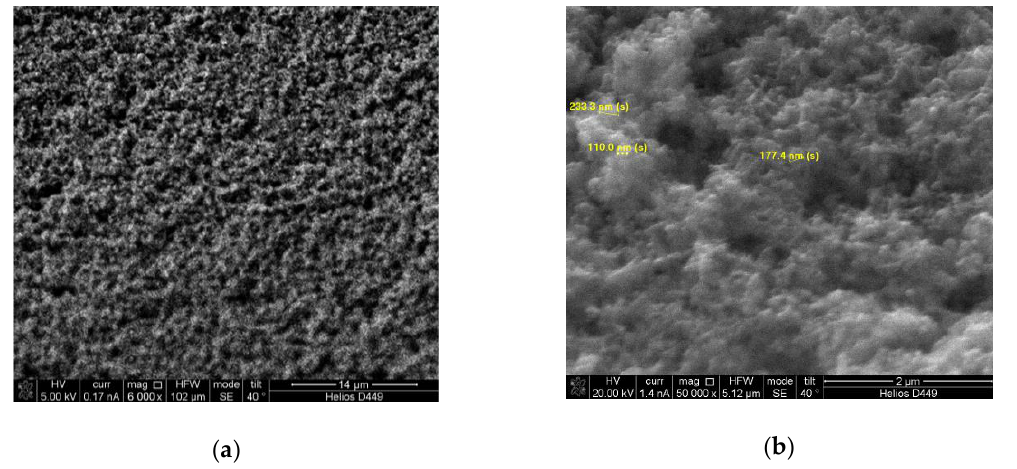
Figure 2. SEM images of the PANI film on a polyethylene substrate: ( a ) low magnification and ( b ) high magnification.